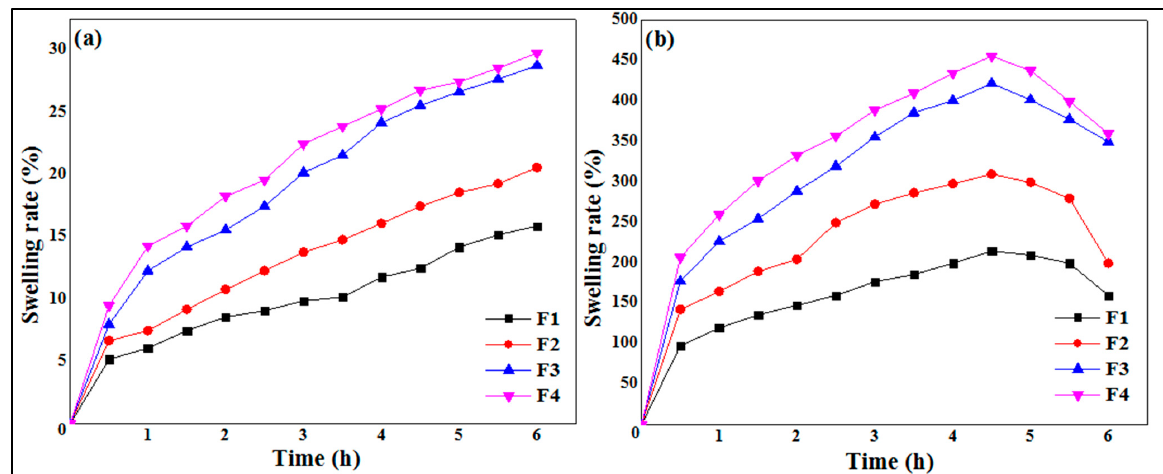
Figure 6. Swelling kinetics of MTH microspheres at pH 1.2 ( a ) and pH 6.8 ( b ).